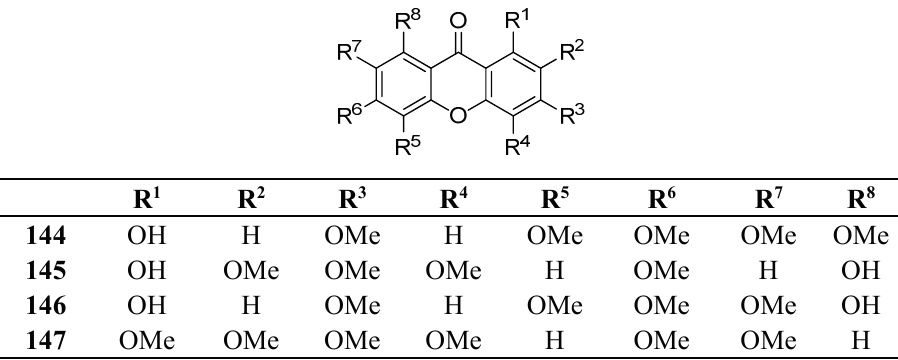
Figure 5. Chemical structures of tested pentaoxygenated xanthones.